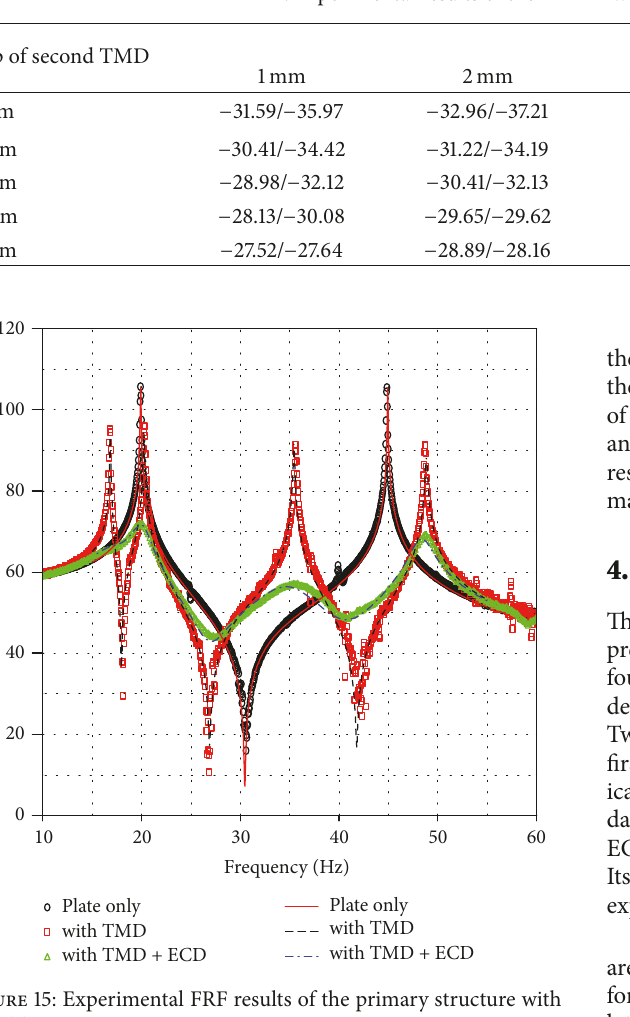
Figure 15: Experimental FRF results of the primary structure with the